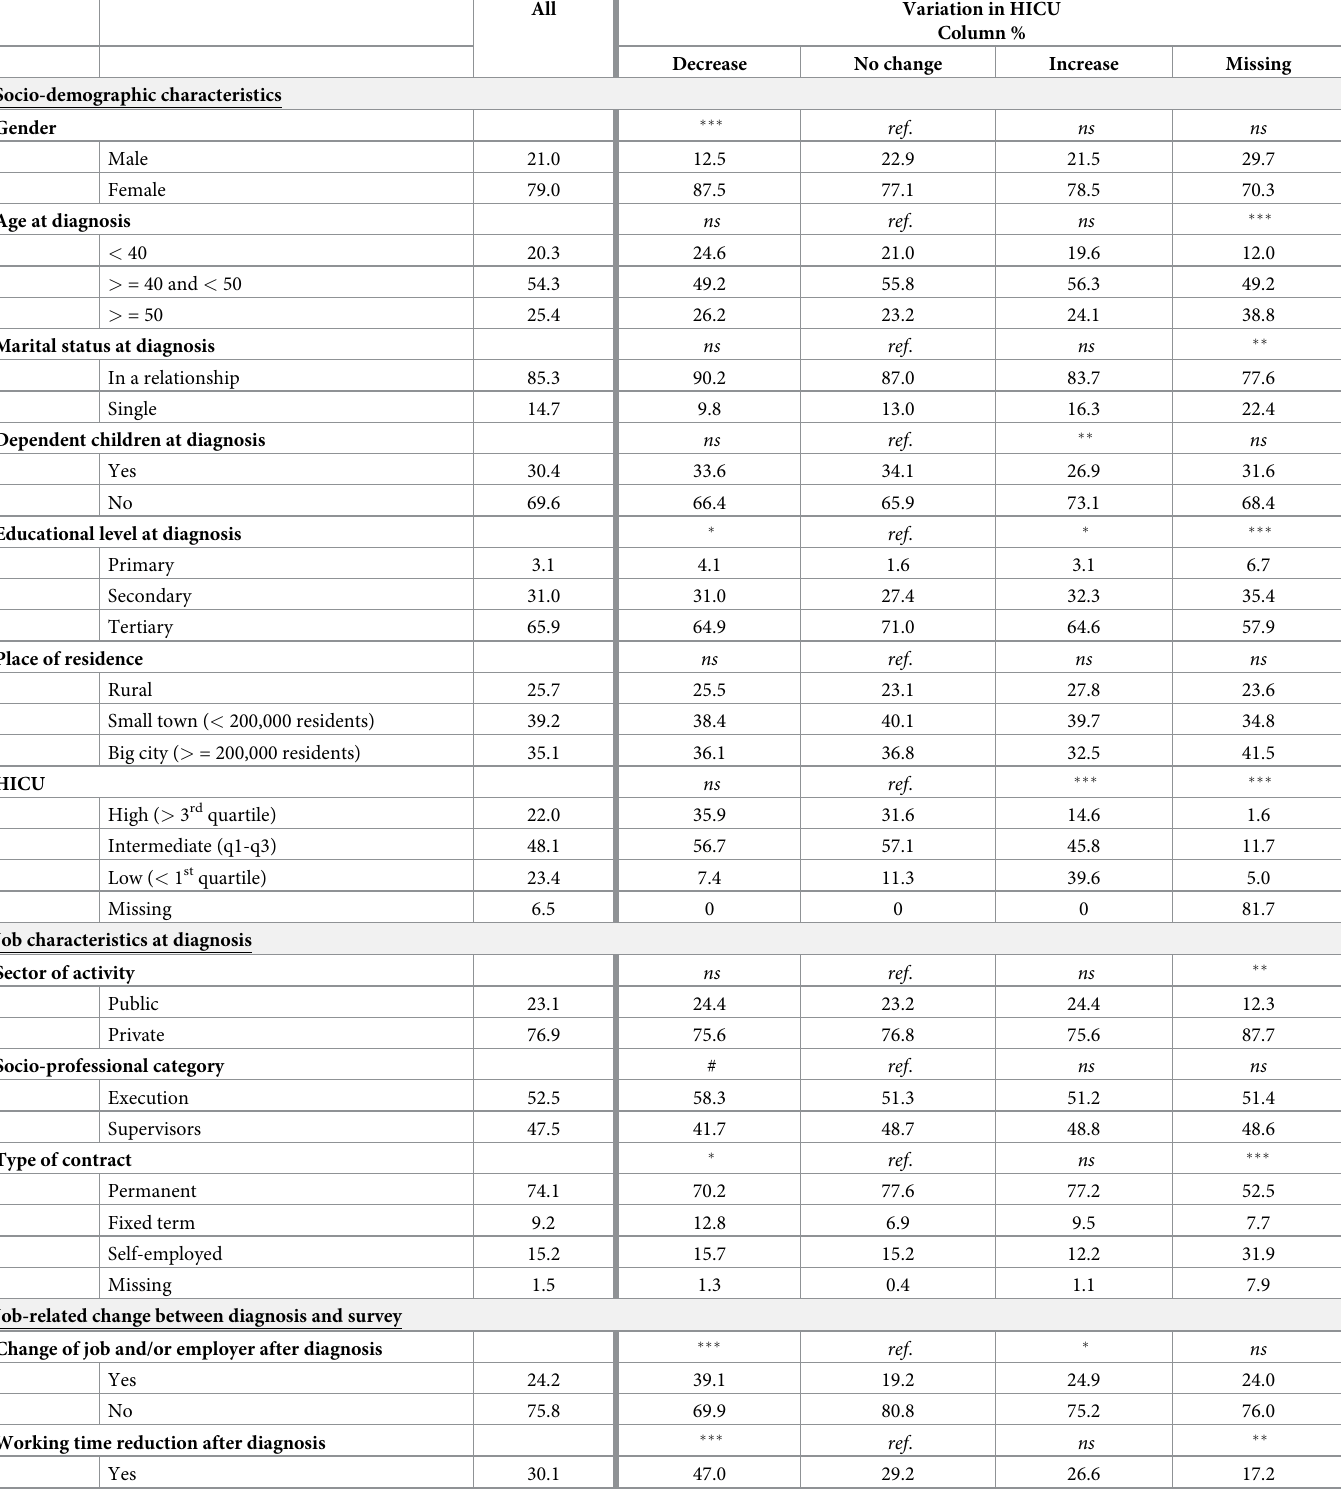
Table 2. Characteristics associated with variation in HICU between diagnosis and survey (N = 1,636).